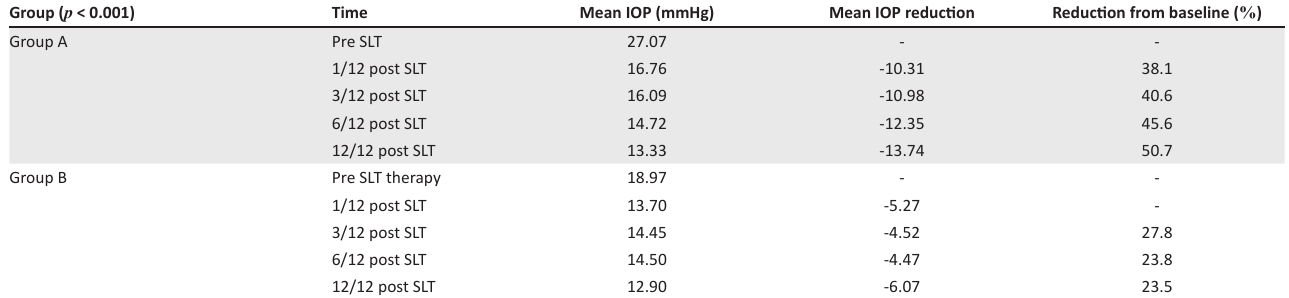
TABLE 3: Mean intraocular pressure drop Group A versus Group B. Group ( p < 0.001)